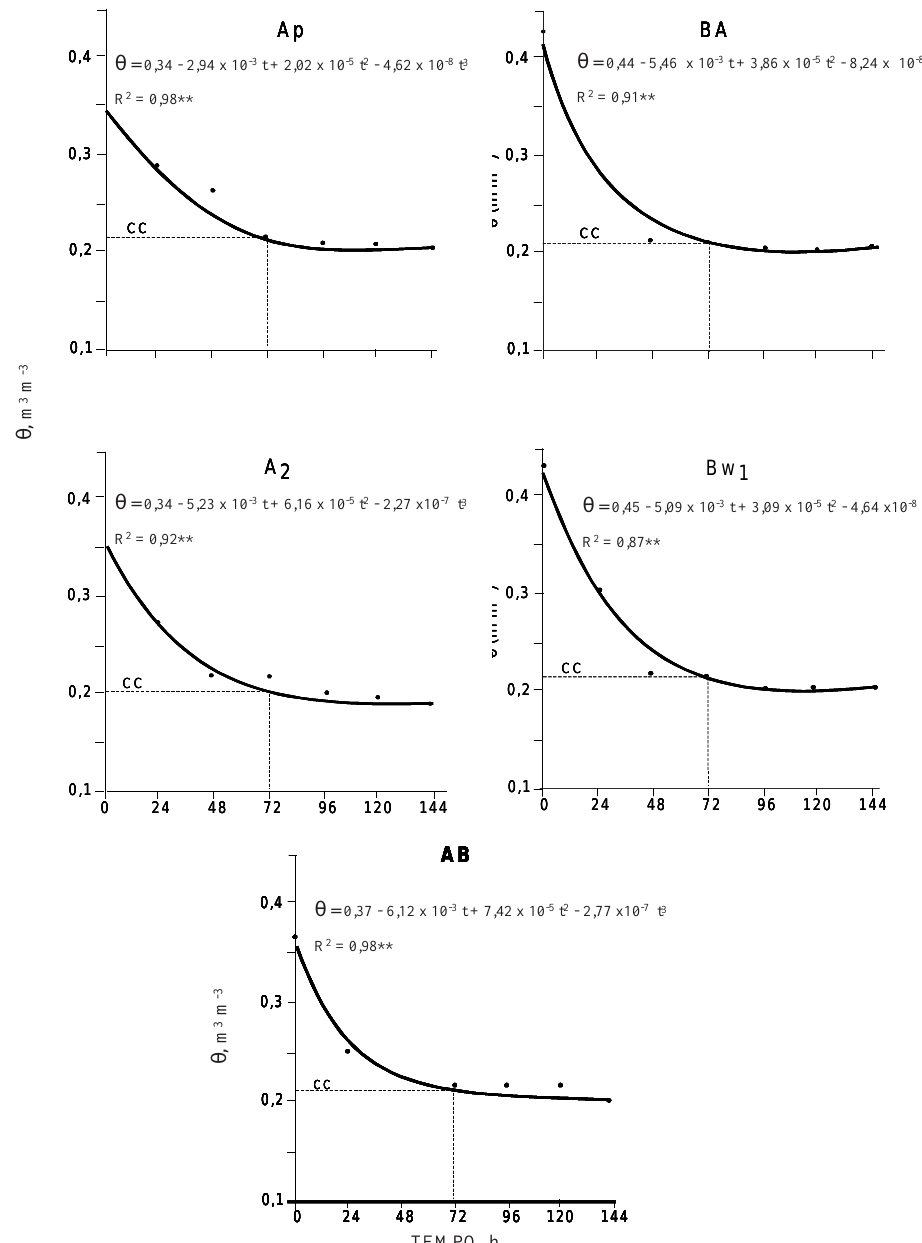
Figura 1. Variação da umidade do solo ( qqqqq ), em m 3 m -3 , em função do tempo, em h, para os cinco horizontes do solo e interpolação por polinômio de terceiro grau (CC = Capacidade de campo). ** significativo a 1%.